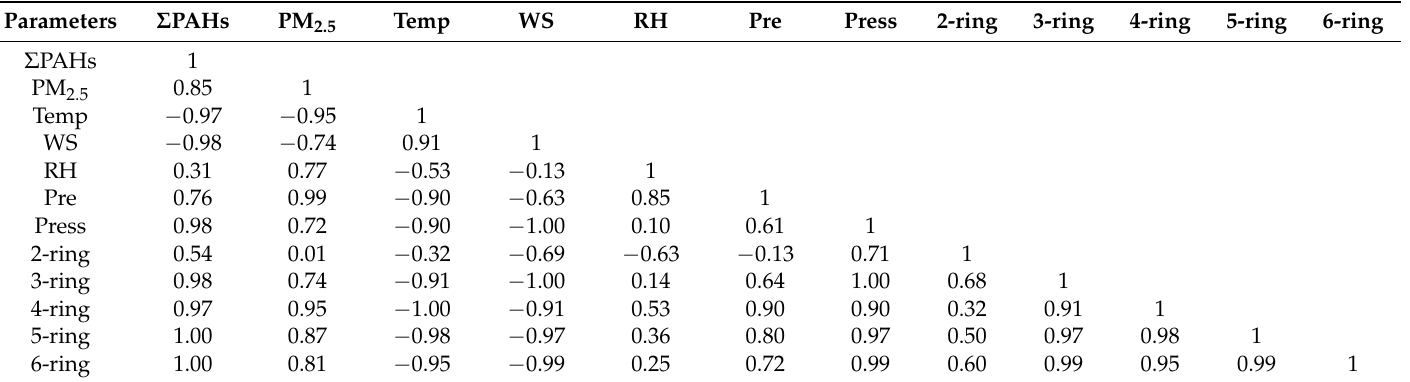
Table 6. Correlations between PM 2.5 and PAH concentrations (for total and different rings numbers), and meteorological parameters. Parameters Σ PAHs PM 2.5